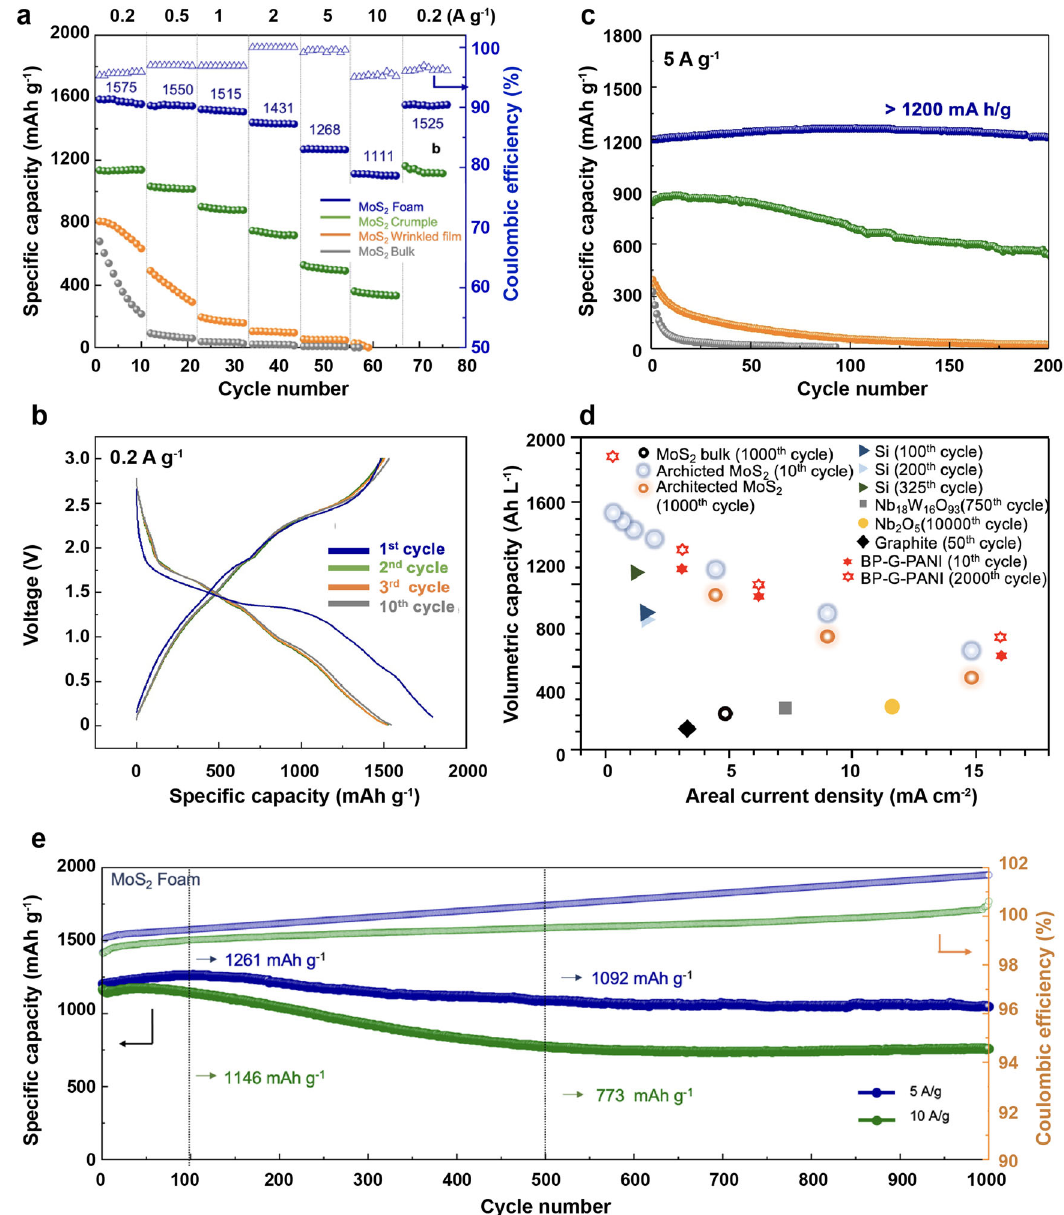
Fig. 2 | Electrochemical performance of MoS 2 foam along with MoS 2 bulk, wrinkled fi lm, and crumples. a Rate capacity performance is measured at differ- ent current densities. b Galvanostatic discharge and charge pro fi les of MoS 2 foam were measured at the fi rst 10 cycles. c Cycling stability comparison at the current density of 5Ag − 1 . d The volumetric capacity of MoS 2 foam outperforms various